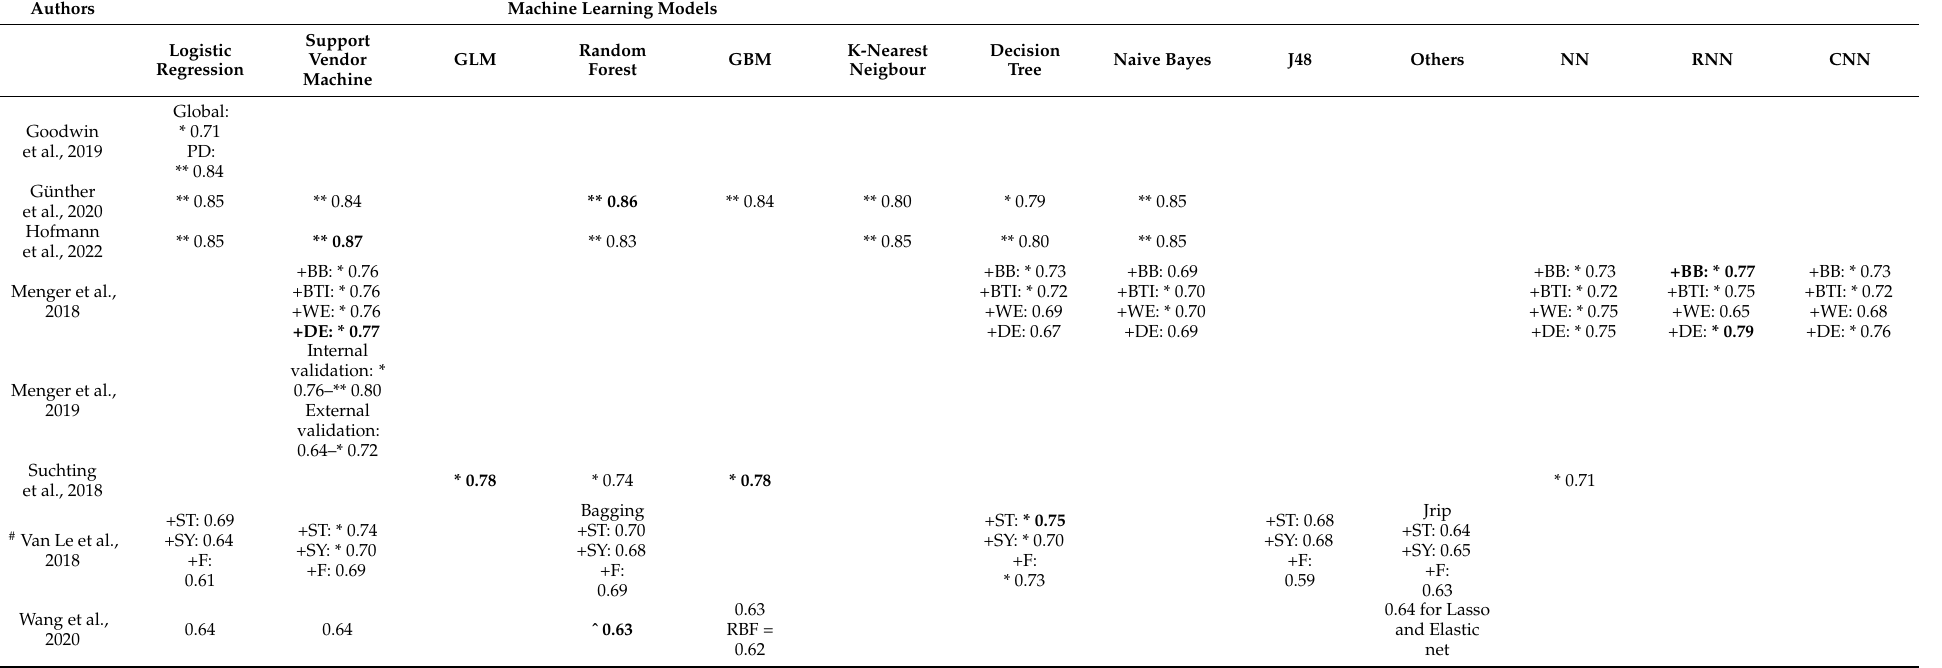
Table 2. AUCs of machine learning